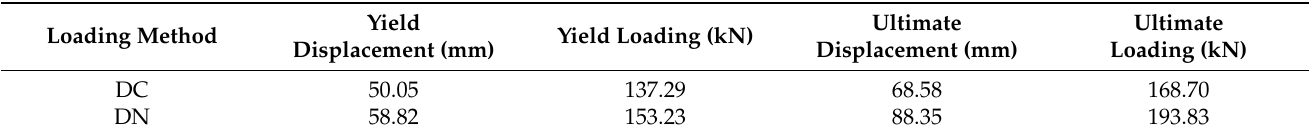
Table 4. Characteristic value of skeleton curves.